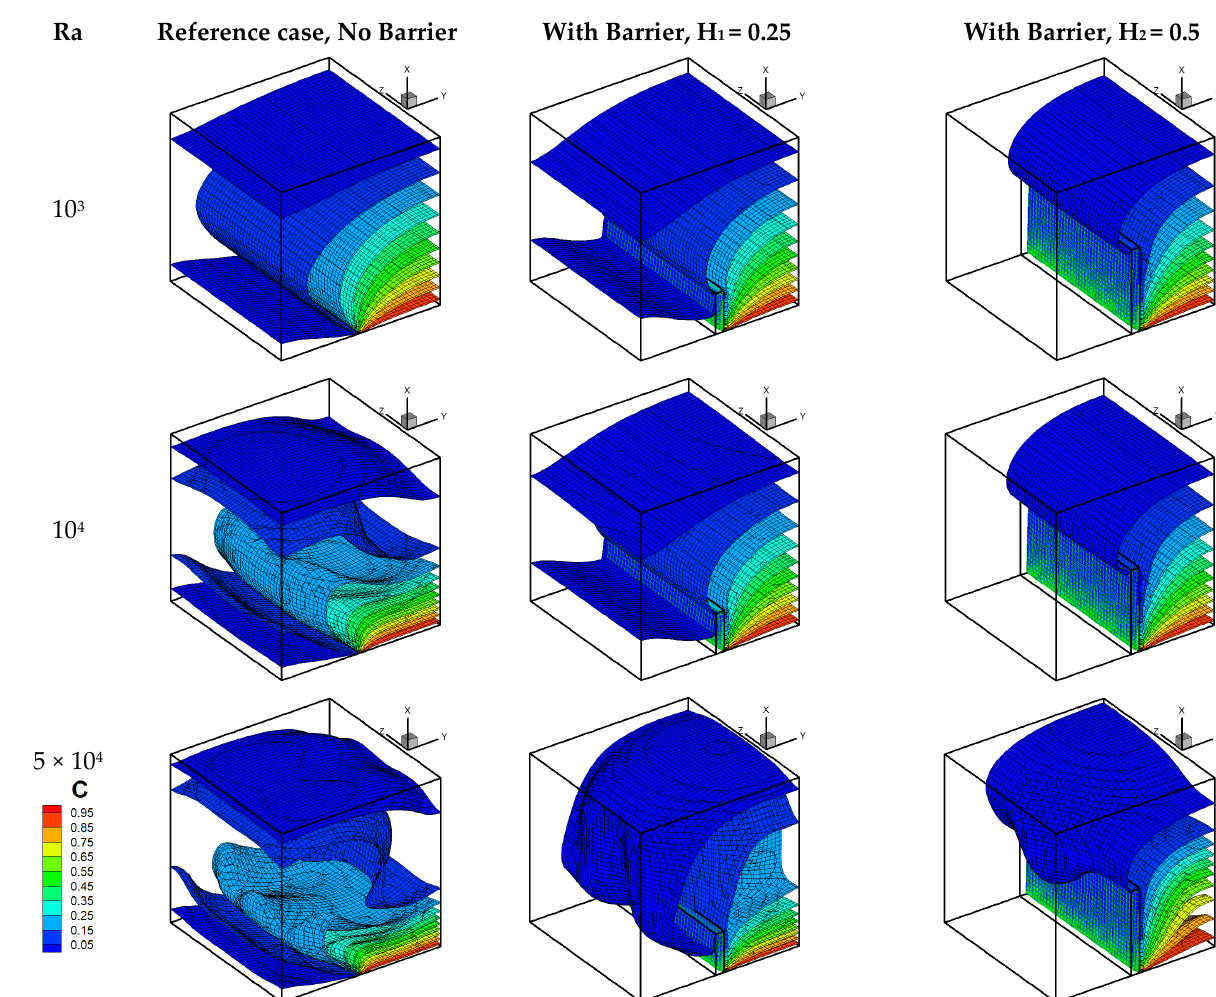
Figure 6. Contaminant iso-surfaces of concentration for different Ra, effect of two barriers’ heights for N = 0.